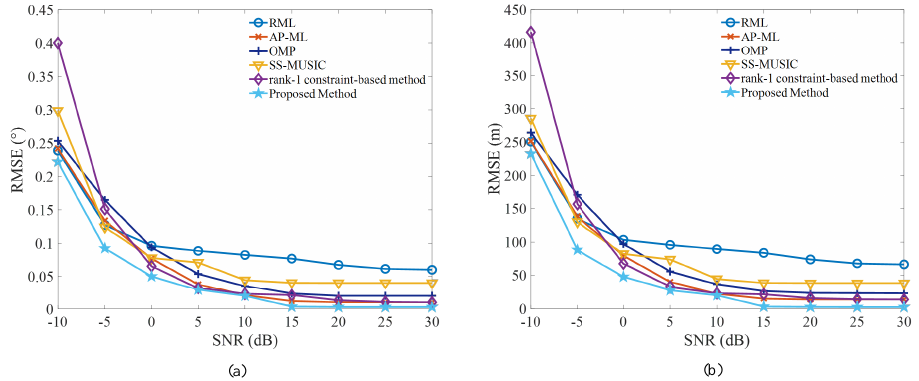
Figure 2. Comparison of RMSE results in terms of target location parameter estimates versus input SNR under the scenario involving a single target and two coherent interference paths. ( a ) The estimate result of target direction. ( b ) The estimate result of target height.